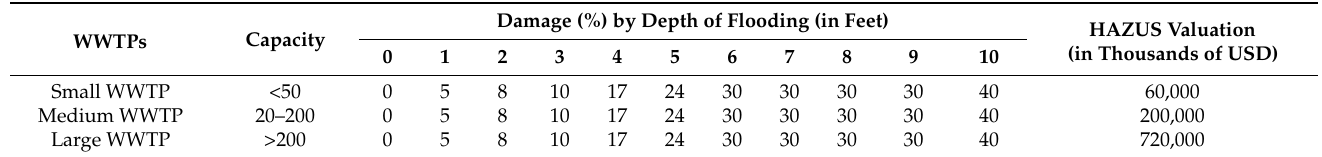
Table 2. WWTPs classification, damage function, and economic